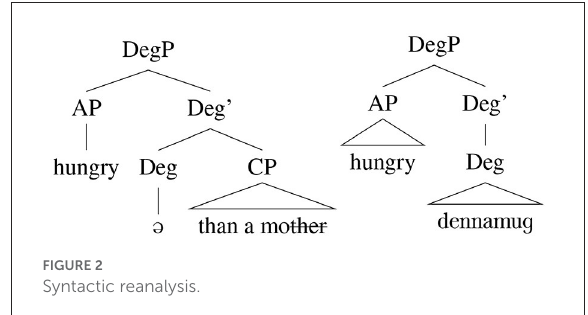
FIGURE2 Syntactic